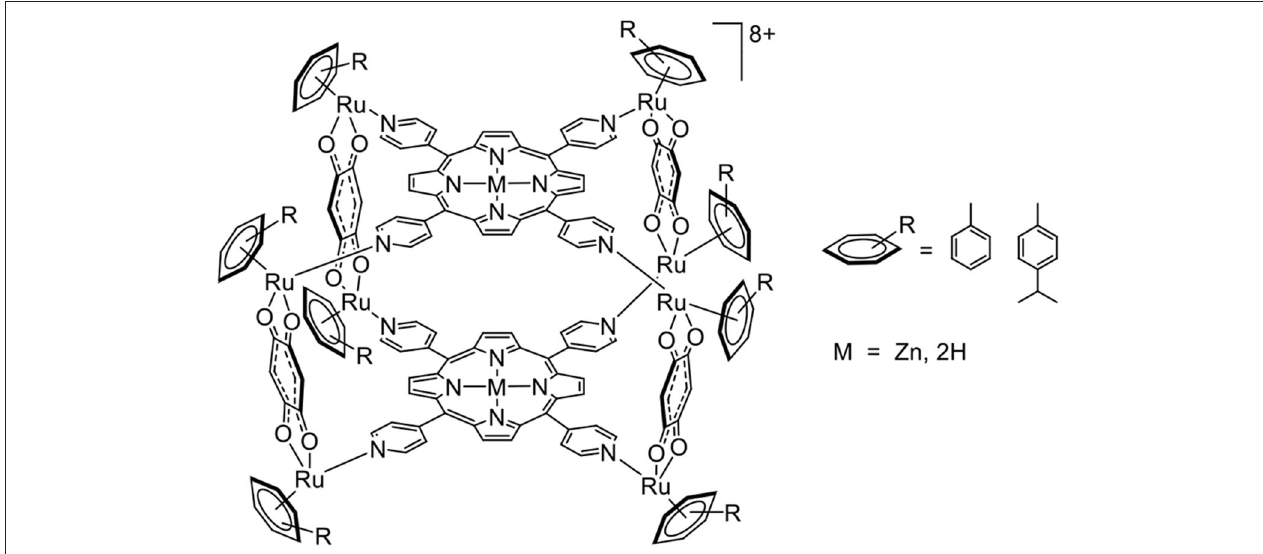
FIGURE 4 | Arene ruthenium metalla-cubes interacting with G-quadruplexes (Barry et al., 2009).